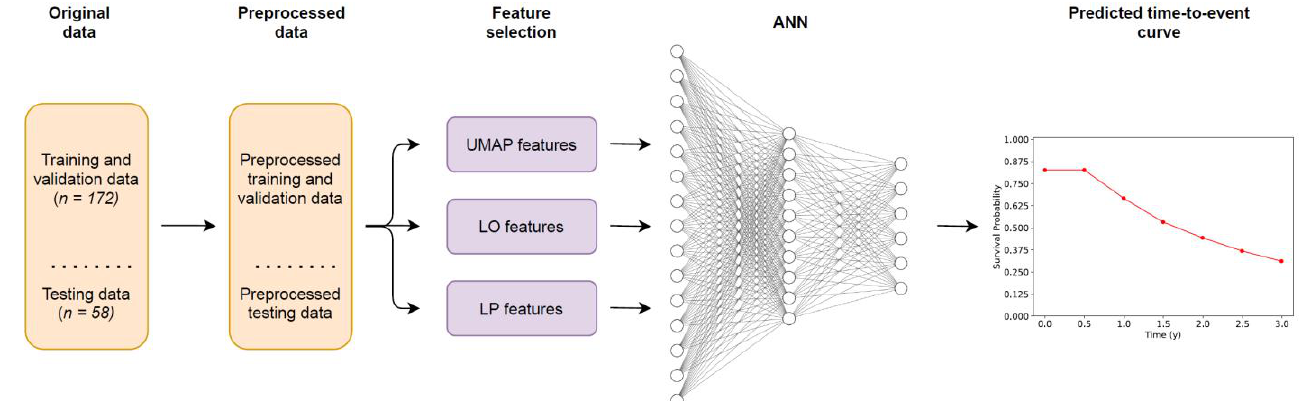
Figure A1. Workflow of the proposed models. The input covariates are first split randomly into training and testing data and preprocessed. Then, three different feature selection methods are used, one algorithmic (UMAP) and two based on expert knowledge (LO and LP). An ANN extended with a previously published survival model is applied on the three different embeddings to predict time-to-event curves for each patient, as shown exemplarily for one patient.